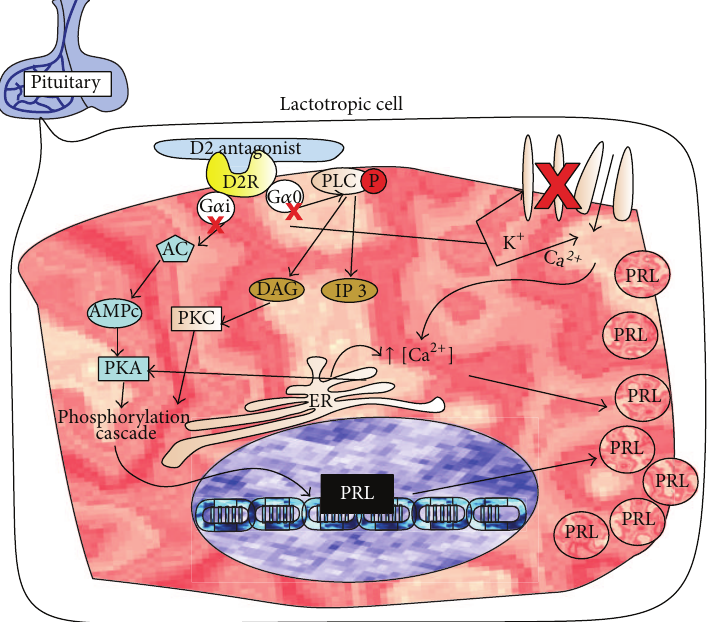
Figure 2: Proposed mechanism of action of dopamine 2 antagonists. In the pituitary gland, antagonists bind to the receptor (D2R) dopamine 2 and induce PRL gene expression, blood level of PRL increases, milk protein synthesis rate increases, and mammary epithelial cells (MEC) proliferation is